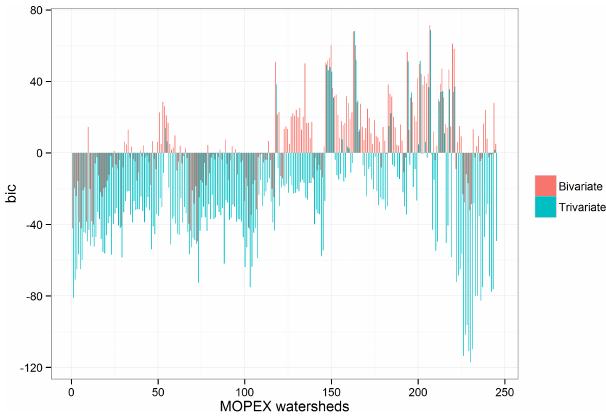
Figure 2. AIC values of the bivariate and trivariate models for the selected MOPEX basins.